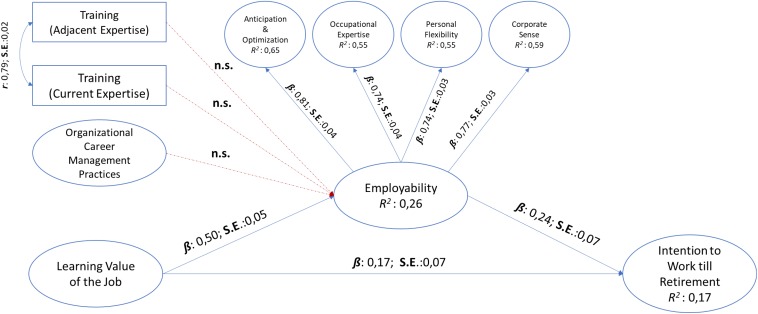
Structural model for Study 2 without control variables.